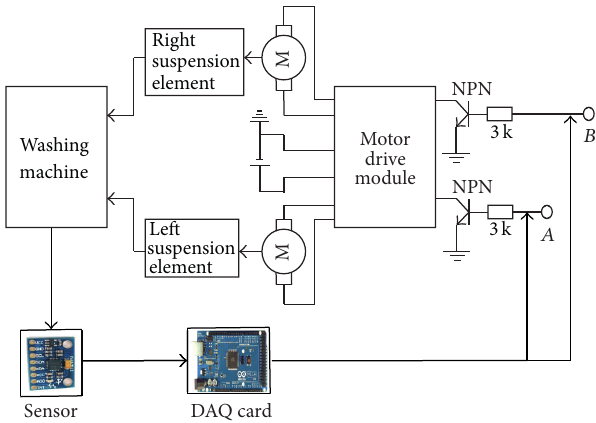
Figure 3: Motor drive module, sensor, and DAQ card connection.